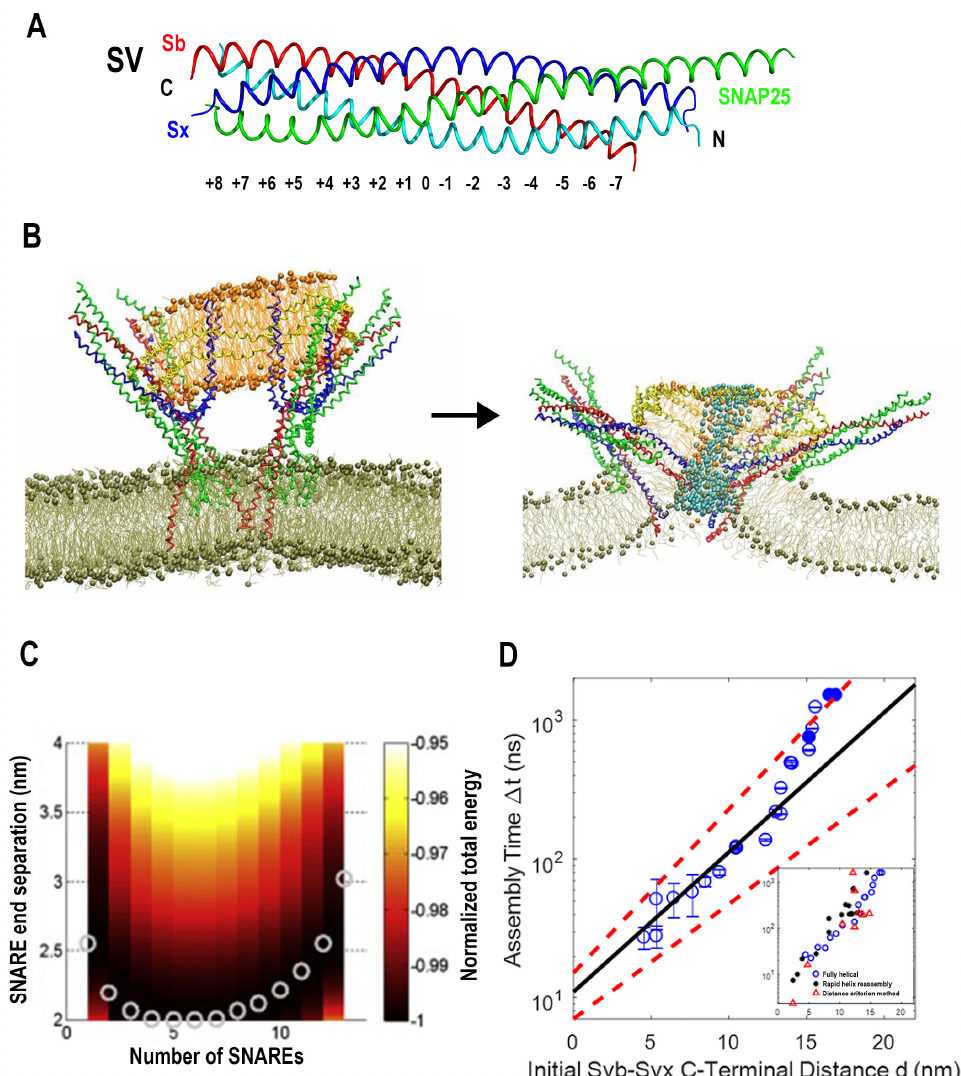
Figure 1. SNARE zippering. ( A ) The structure of the SNARE bundle with the denoted layers [47]. ( B ) The initial (left) and the final (right) states of the molecular system mimicking the SV and PM bilayers attached to each other by four SNARE bundles. Red: Sx, blue: Sb, green: SNAP25. Blue spheres denote water molecules diffusing through the open pore in the final state. Reproduced with permission from [57]. ( C ) The separation of an SV and the PM at equilibrium plotted against the number of the SNARE complexes mediating the SV-PM attachment [60]. Note a steep drop as the number of the SNARE complexes increases from one to two, and a further reduction in the SV-PM separation as the number of the SNARE complexes increases to three. Note also the plateau, as the number of the complexes increases further. ( D ) The assembly time of the SNARE complex depends exponentially on the initial separation of the Sb and Sx C-terminals [59]. The inset shows the results obtained using three different models of the helix assembly, which largely